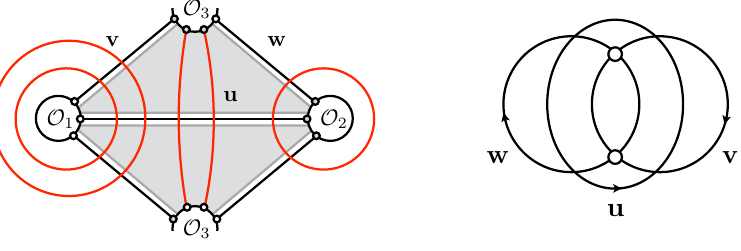
V n;m;n . We cut (cid:3) O 3 (cid:24) . We denote by u the set of rapidities O 3 u = v + w + m . In the right panel, we represent the hexagon j j j j j j